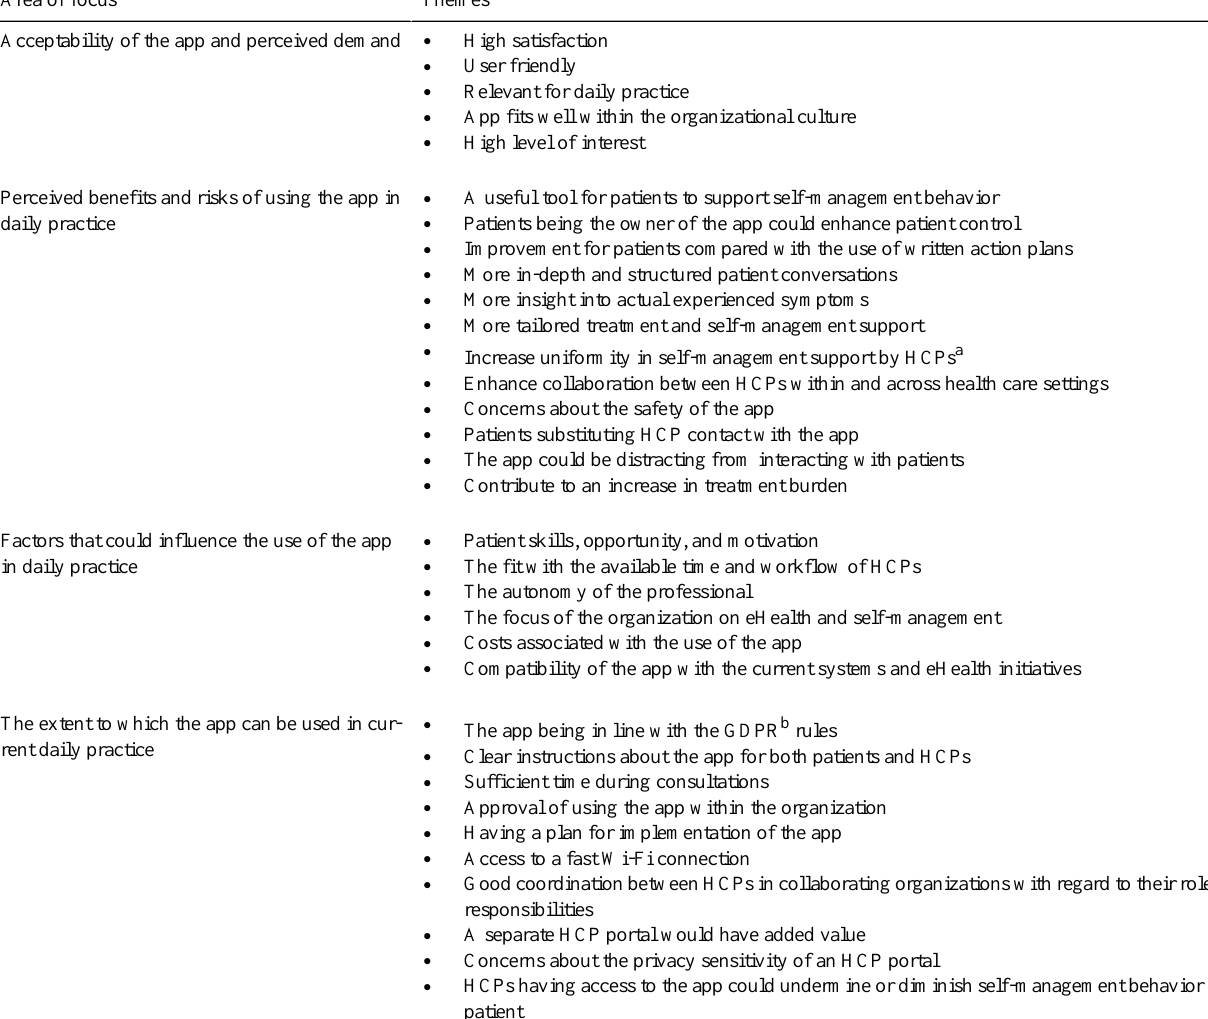
Table 3. Overview of the